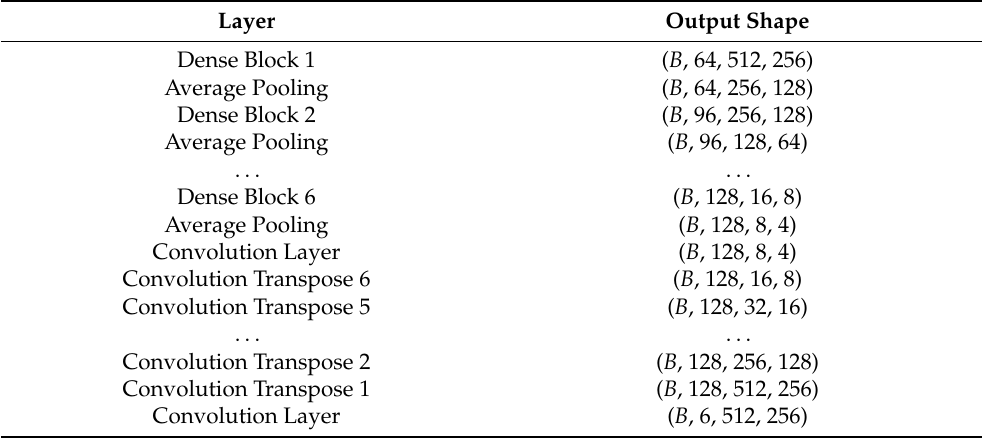
Table 1. Output shape of each layer in Dense-UNet.